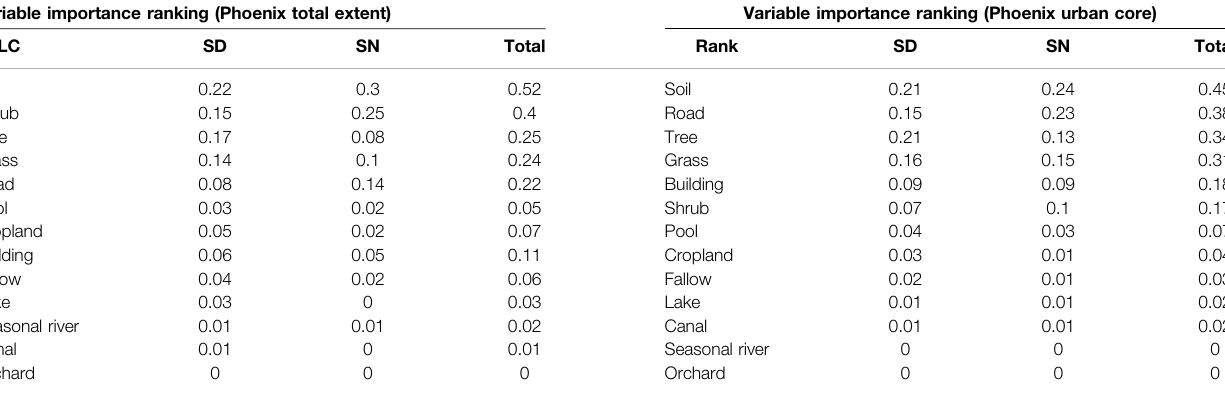
TABLE 3 | Importance of LULC composition for explaining LST patterns across Phoenix according to RF models for Phoenix total extent and the urban core only. Variable importance ranking (Phoenix total extent)